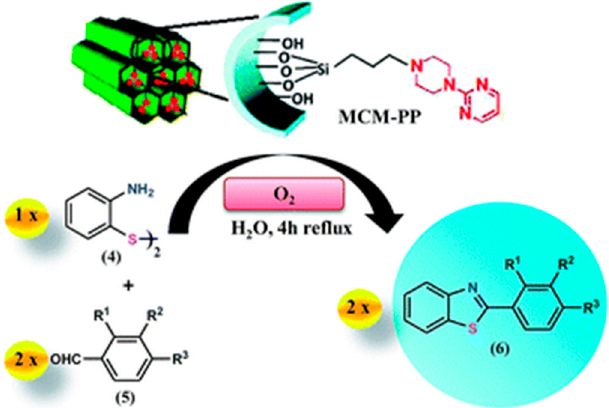
Figure 17. MCM-PP ( 3 ) catalyzed synthesis of benzothiazoles. Reproduced with permission from [25]. Copyright 2015 American Chemical Society.